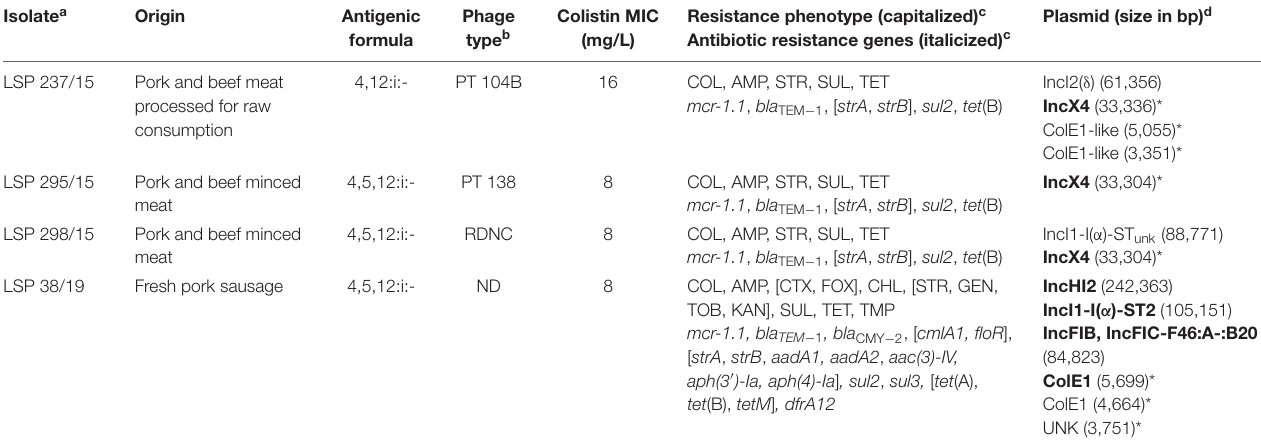
Plasmid (size in bp) d